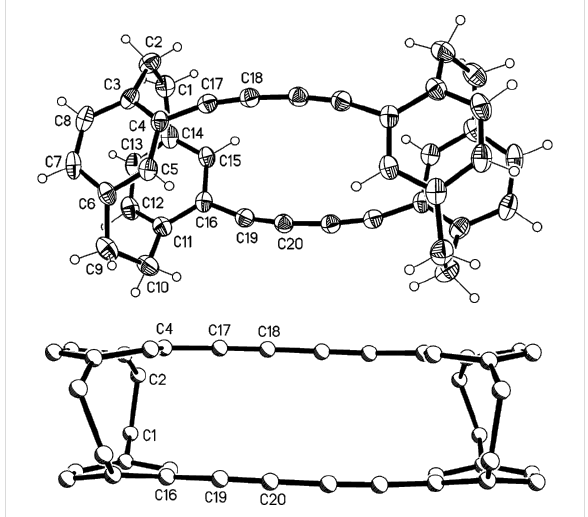
Figure 2: Above: The molecule of compound 12 in the crystal; ellip- soids represent 50% probability levels. Only the asymmetric unit is numbered. Below: Alternative view direction (arbitrary radii, without H atoms) showing the “parallel” geometry via the additional